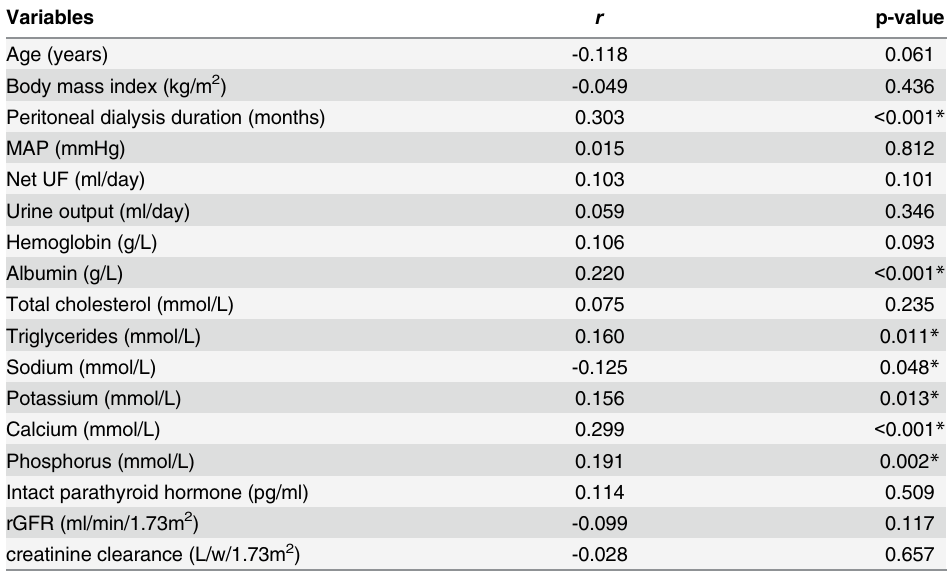
Table 2. Correlation analysis for variables and baseline serum magnesium